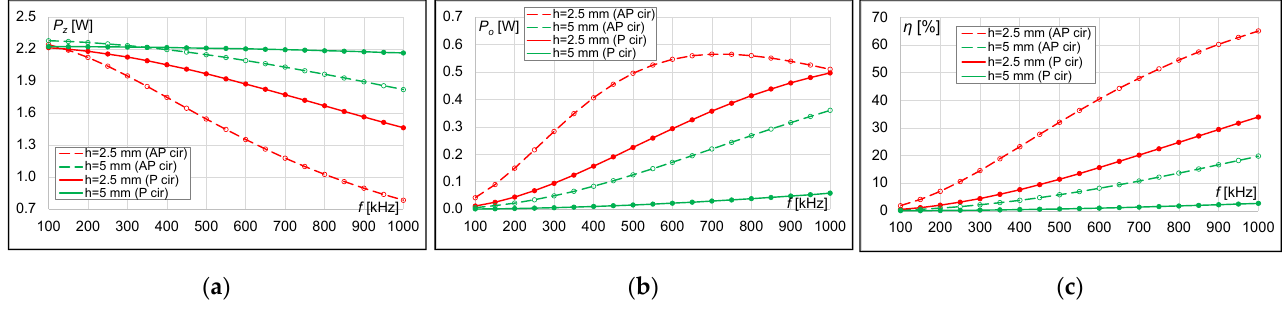
Figure 7. Results for circular coils with r = 5 mm and the number of turns n = 20 at two distances ( h = 2.5 mm and h = 5 mm): ( a ) transmitter power, ( b ) receiver power, ( c ) power transfer efficiency.